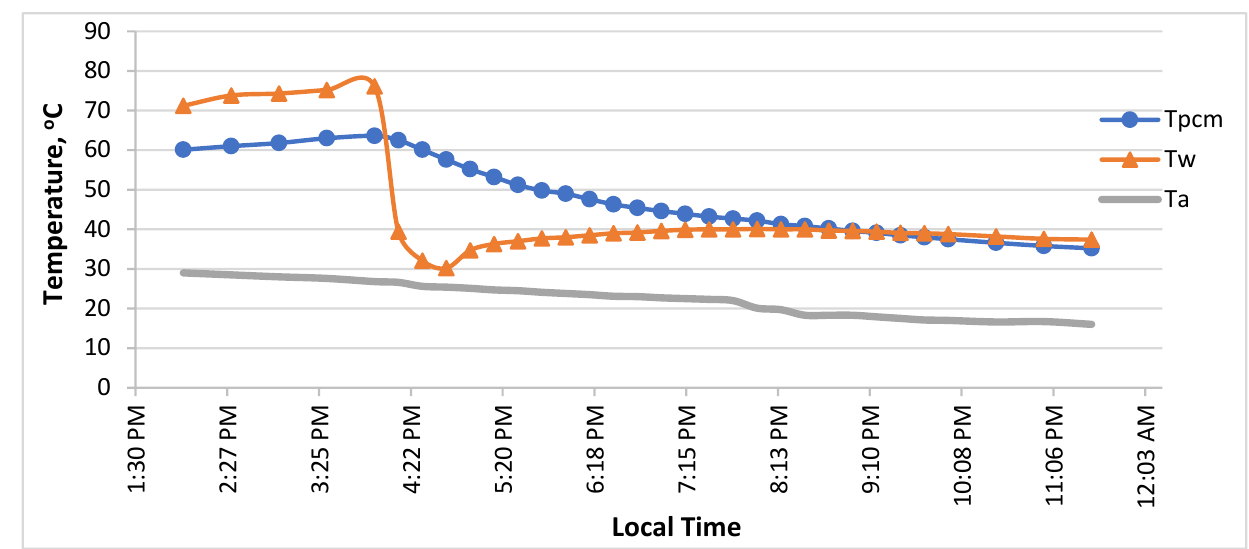
Figure 8. Temperature history of the system through complete hot water consumption.